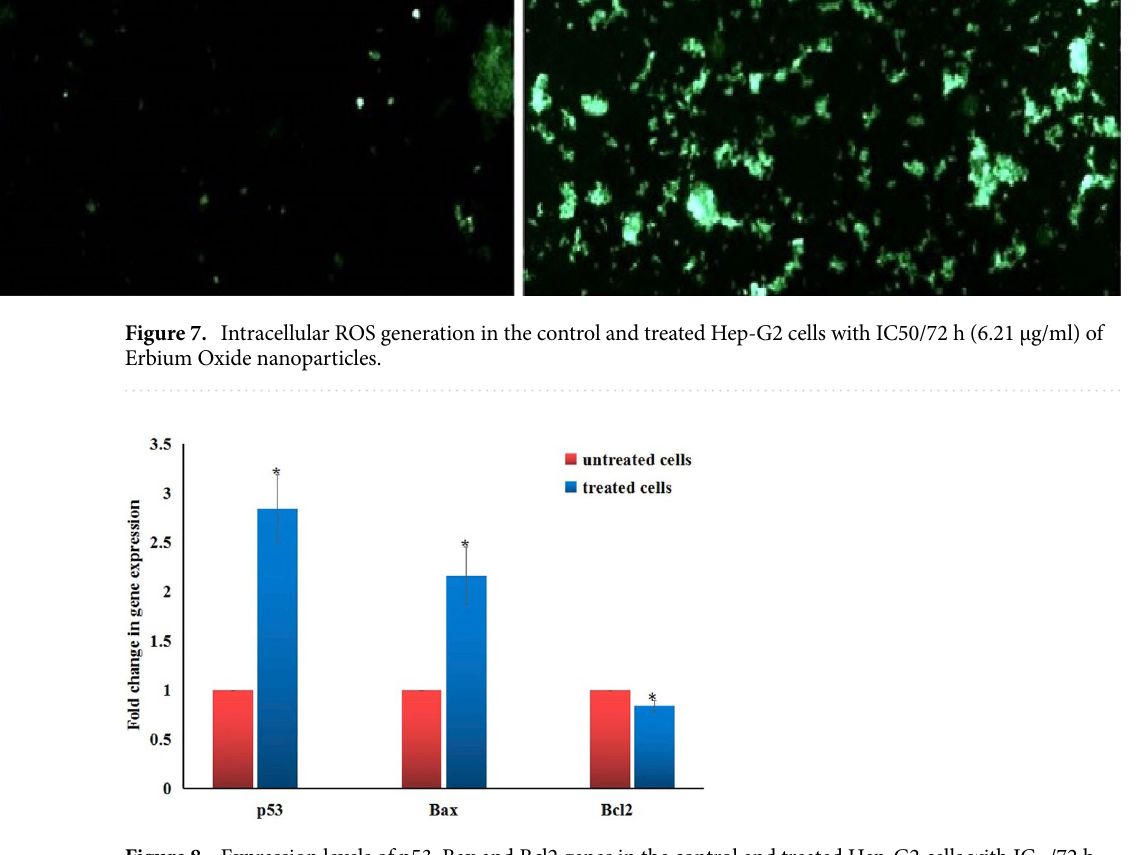
Figure 8. Expression levels of p53, Bax and Bcl2 genes in the control and treated Hep-G2 cells with IC 50 /72 h (6.21 µg/ml) of erbium oxide nanoparticles. Results are expressed as mean ± SD. *Indicates statistical significant difference from the compared control at p < 0.05 using student